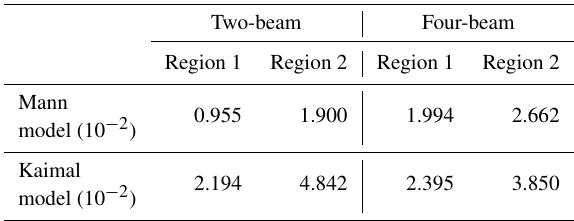
Table 3. Comparison of the RMSE between measured and model- derived coherence for the two- and four-beam lidars in regions 1 and